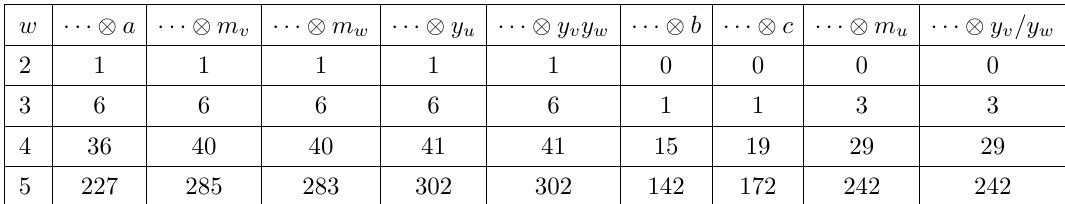
Table 22 . The number of distinct terms that have (cid:12)rst entry a and a given last entry in the space of weight- w symbols constructed out of the 40 adjacent entry pairs given in eqs. (3.6) and (3.7). This number depends on the symbol alphabet used; we express these symbols in terms of the alphabet